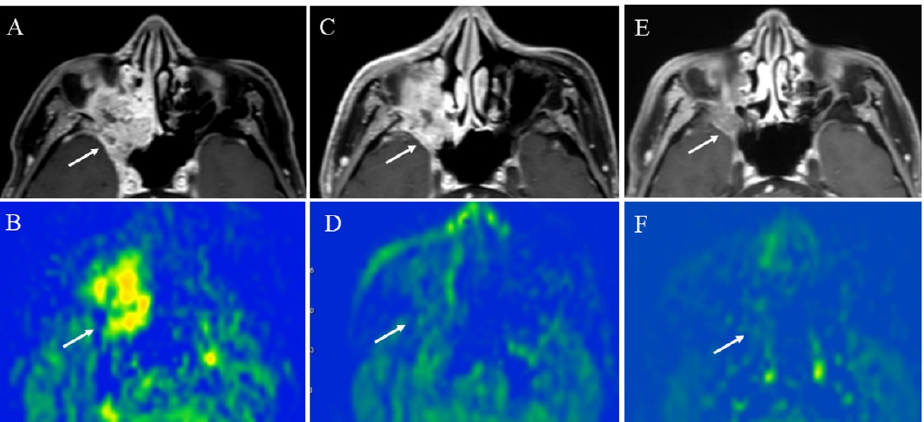
Figure 14. A 64-year-old male with squamous cell carcinoma of the right maxillary sinus: ( A ) Pretreatment contrast-enhanced T1-weighted image shows a poorly marginated mass (arrow); ( B ) the pCASL image shows high TBF (arrow) (mean of 102.9 mL/100 g/min). During chemoradiotherapy, the tumor slightly decreased in size (arrow) ( C ), whereas significantly decreased in TBF (arrow)(mean of 44.8 mL/100 g/min) ( D ). After chemoradiotherapy, the tumor decreased in size (arrow) ( E ) and further decreased in TBF (arrow) (mean of 16.7 mL/100 g/min) ( F ).